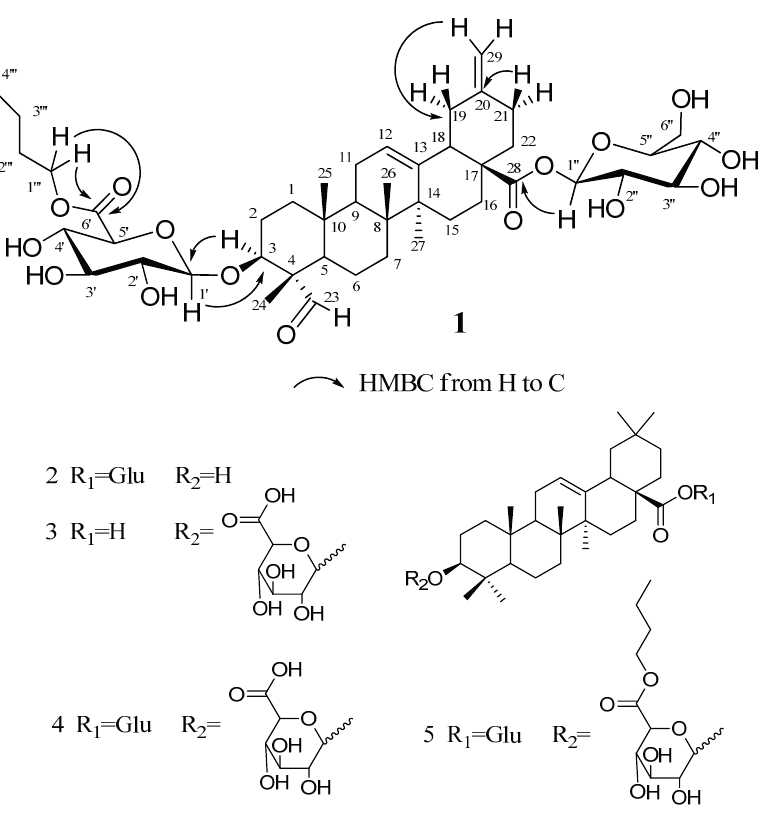
Figure 2. Key HMBC correlations for Compound 1 and the chemical structures of Compounds 2 – 5 isolated from S. bigelovii Torr.